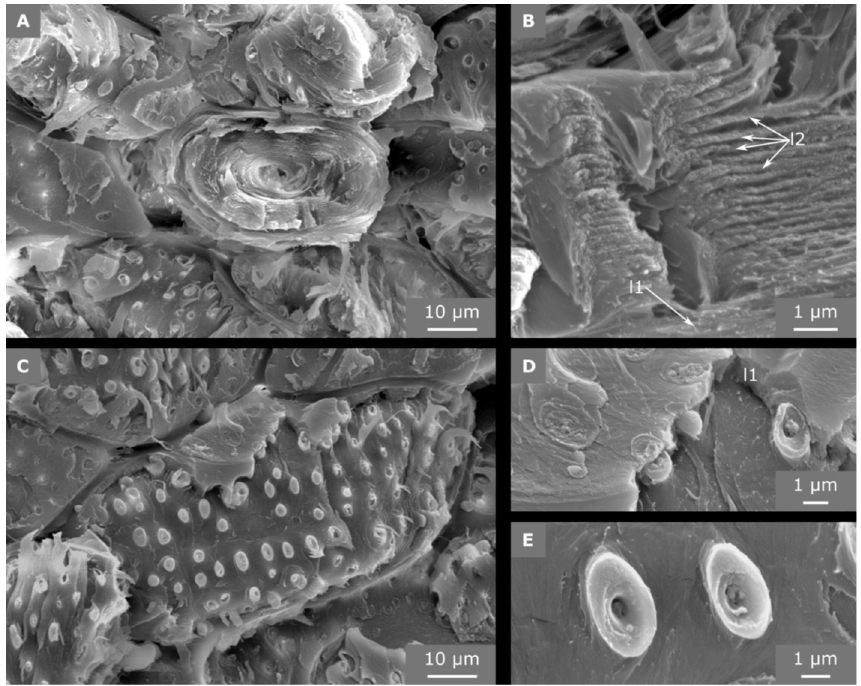
Figure 7. SEM images of sclereid cells from fracture surfaces. The cross-section shows the many cell wall layers that fill almost the entire cell lumen ( A ). The cell wall is traversed by pit canals ( B ), to which the lignified secondary cell wall layers (l2) align. In a sclereid cell oriented longitudinally to the direction of fracture, the crack has run into the cell wall and detached the outermost cell wall layers ( C ). When the primary cell wall (l1) and middle lamella is partly broken, the pit cavity becomes visible ( D ) and the bordered pits emerge from the fracture surface ( E ).